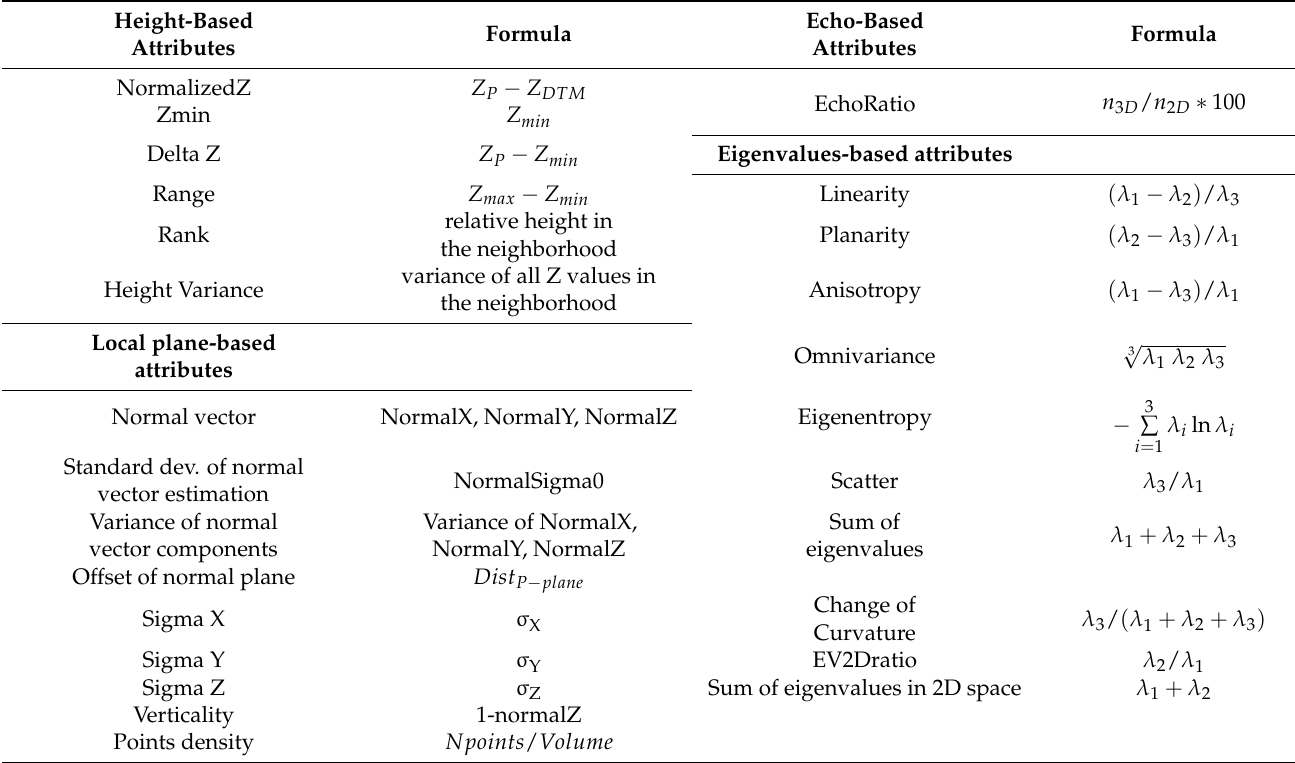
Table 3. Attributes computed for each UAS off-ground point in a cylindrical